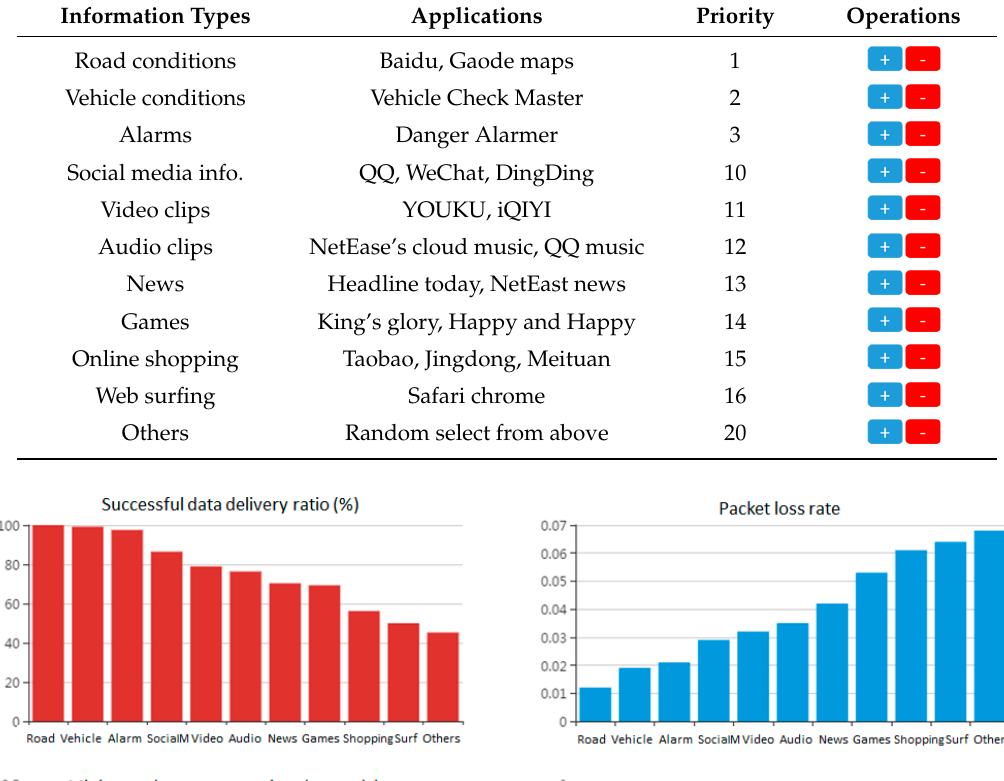
Figure 19. Successful delivery ratio under different simulation time and content sending interval. Table 2. Configuration of the priorities of different types of content.